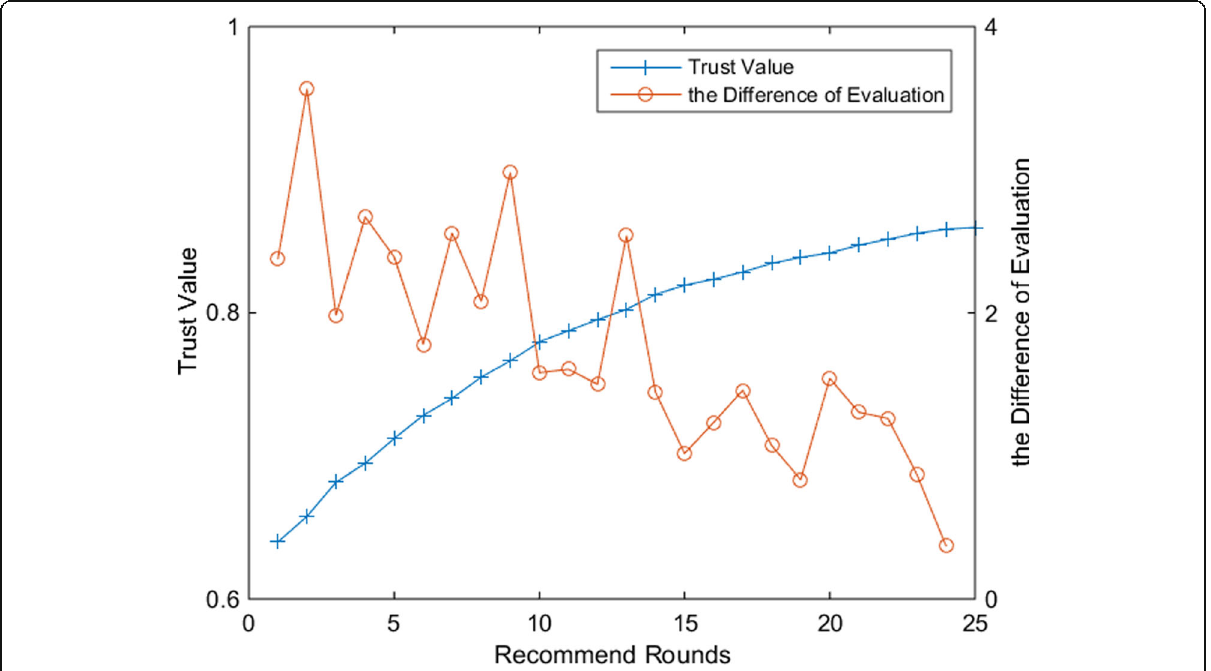
Fig. 7 Correlation graph of evaluation and trust (with RLS)